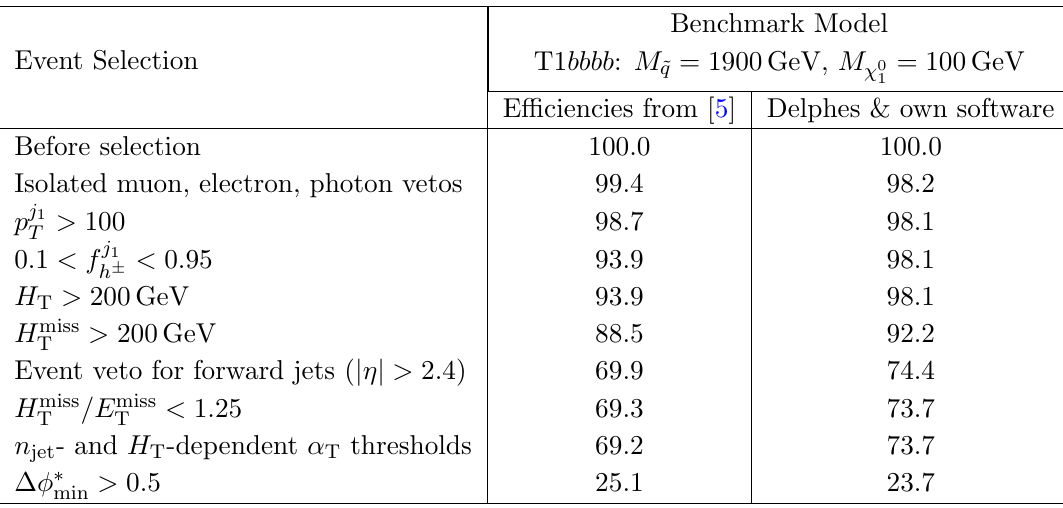
Cumulative percentages of events passing the event selections compared with those from [5] for a standard reference benchmark model, T 1 bbbb